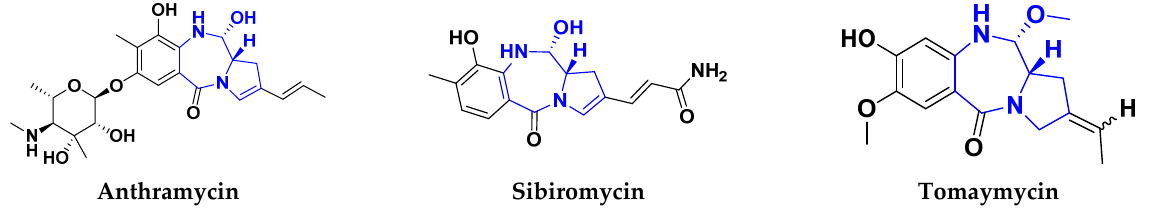
Figure 104. Pyrrolo ‐ benzodiazapine containing FDA approved anticancer drug. Figure 104. Pyrrolo-benzodiazapine containing FDA approved anticancer